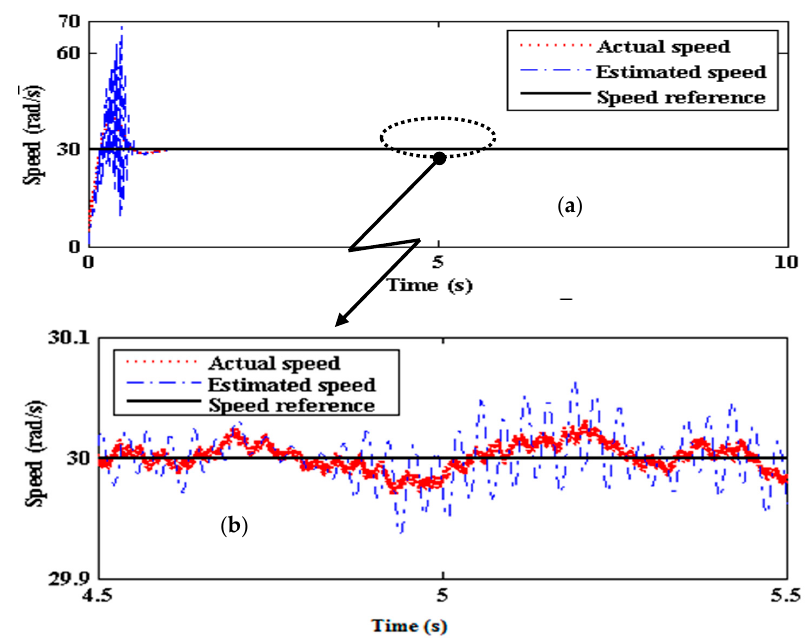
Figure 18. ( a ) estimated speed of SMLO 2 ( b ), zoomed version of ( a ).